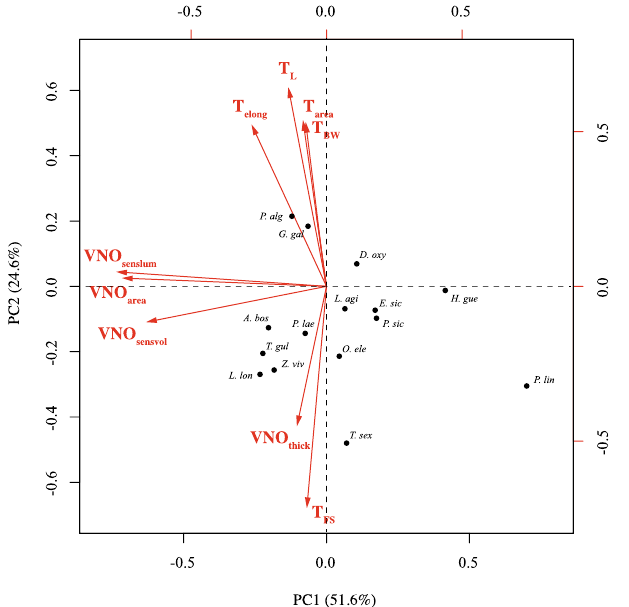
Figure 2. Biplot of the phylogenetic principal component analysis (pPCA) for the first two principal components (PCs) of 15 lacertid species. Red arrows indicate the PC loadings. The percentages of variance explained by the PCs are shown in the axis labels.